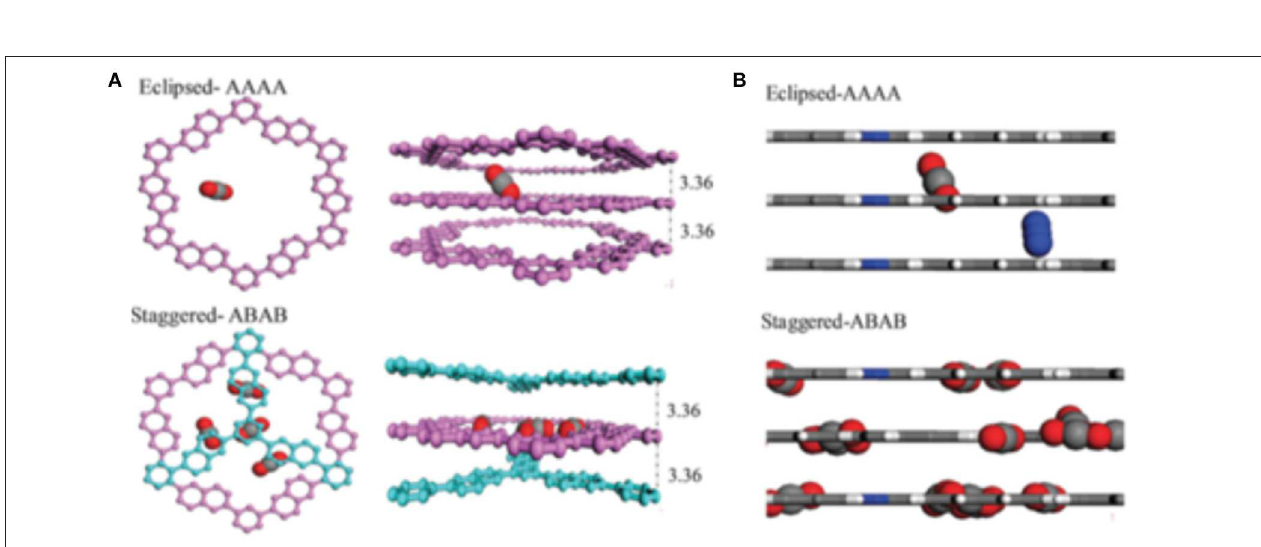
FIGURE 12 | (A) Adsorbed CO 2 in eclipsed (top) and staggered (bottom) CTF-2 and (B) CO 2 -N 2 gas mixture in the eclipsed (top) and staggered (bottom) CTF-2. Reprinted with permission © 2014 The Royal Society of Chemistry.